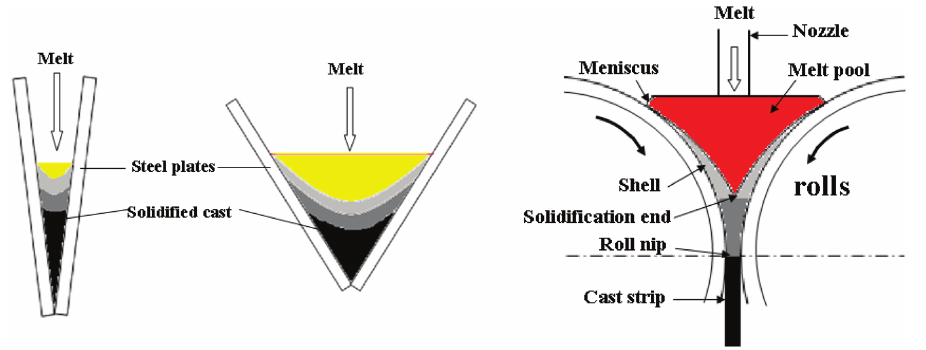
Figure 8: A schematic plot of the V shape mold casting and the twin roll strip